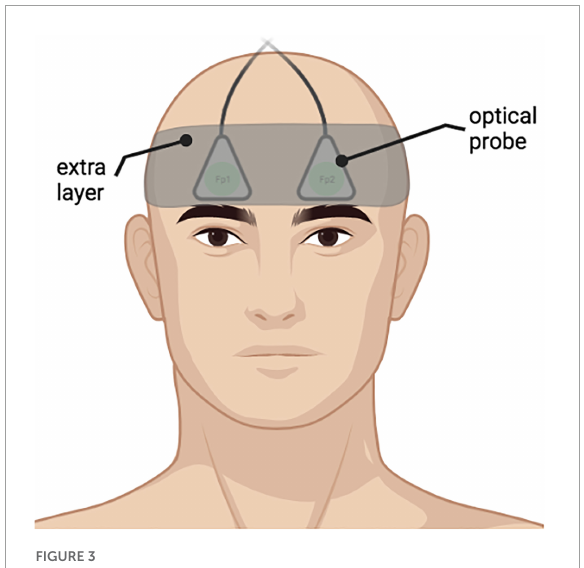
FIGURE3 An example of placement of the optical probes on a participant bilaterally on Fp1, Fp2 positions according to “10–20 system”. An extra fabric layer was applied on top of the probes to ensure data quality during